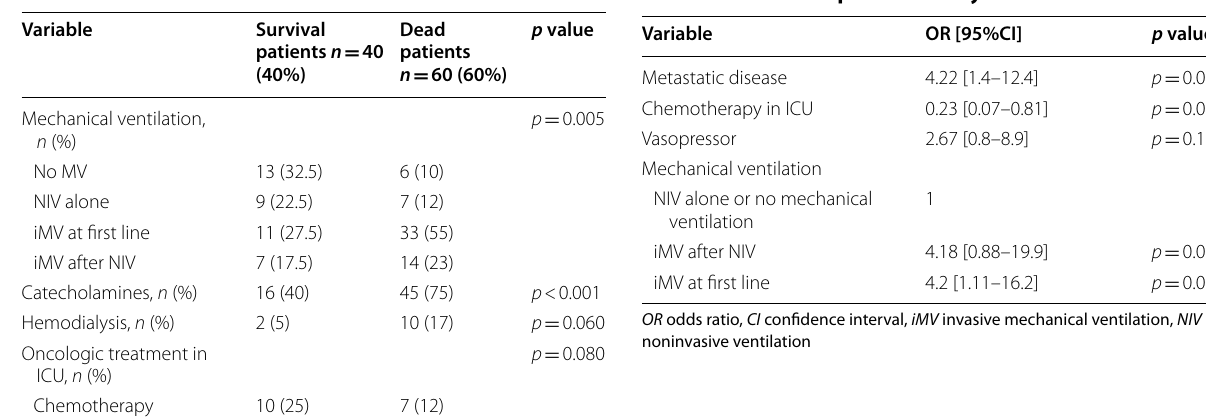
Table 4 Multivariate analysis of risk factors